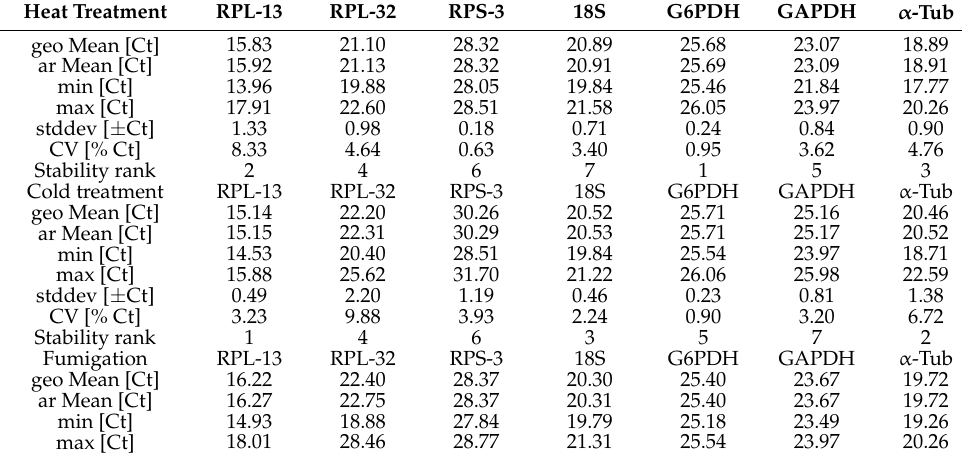
Table 6. Gene expression stability of tested reference genes of B. dorsalis exposed to different phy- tosanitary treatments analyzed using